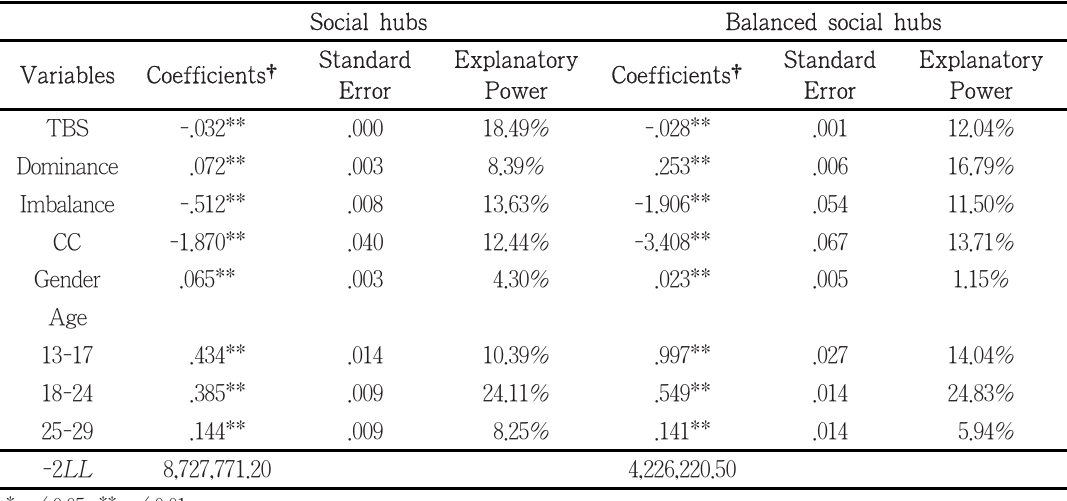
<Table 7> Cox Proportional Hazard Model Estimation Results for the lifespan of social